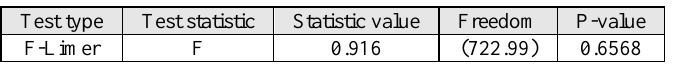
Table 3: Results of F-Limer Test for model 1